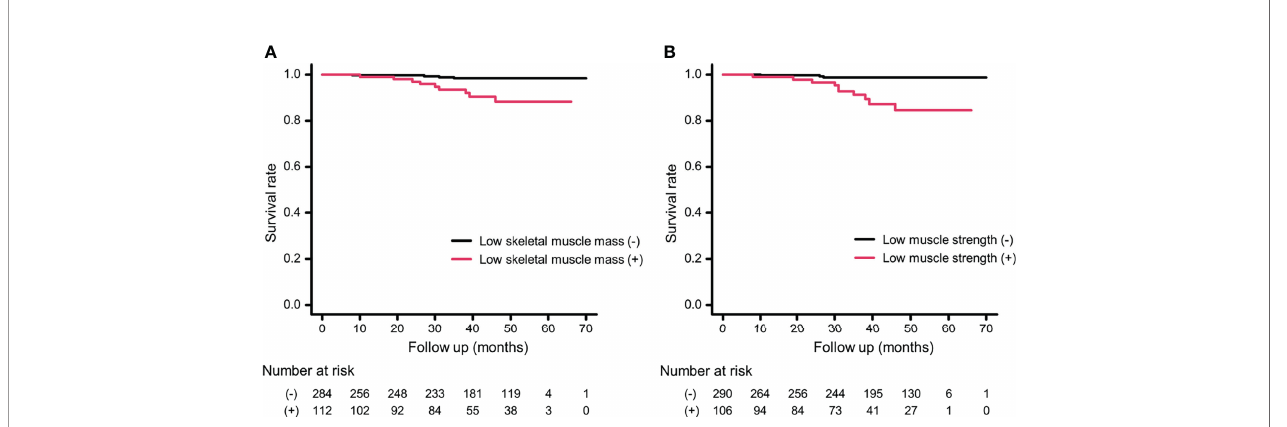
FIGURE 3 | Kaplan-Meier survival curve according to the presence or absence of low skeletal muscle mass or low muscle strength. (A) The presence or absence of low skeletal muscle mass. (B) The presence or absence of low muscle strength. According to the log-rank test, both p < 0.001.